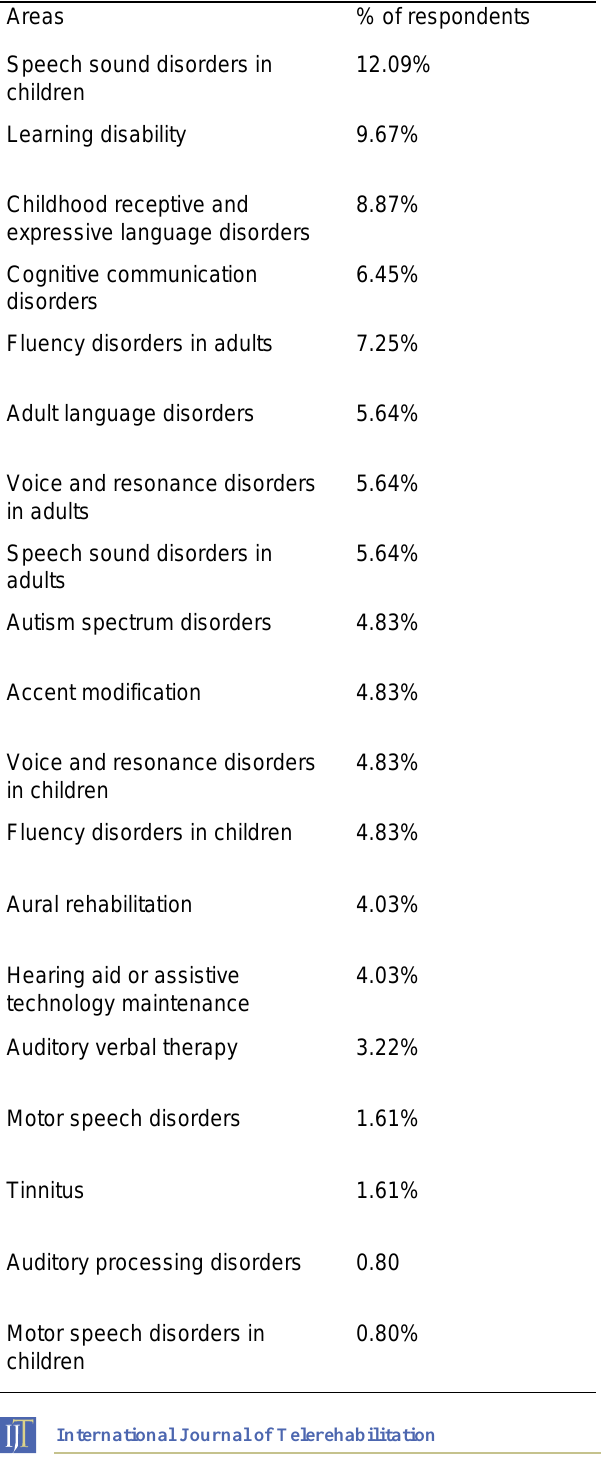
Table 3. Disorders Served Through